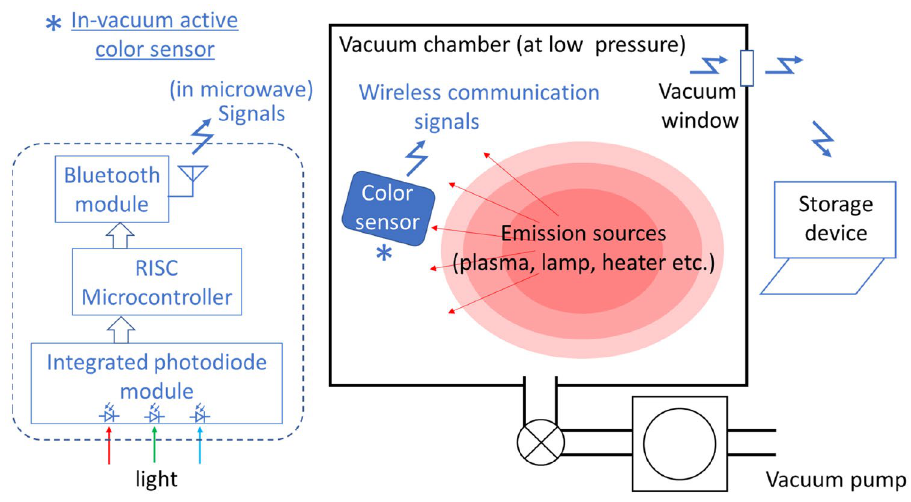
Figure 1. Conceptual view of edge-computing and wireless-communication system used in this study with a block diagram of the electronics in the colour